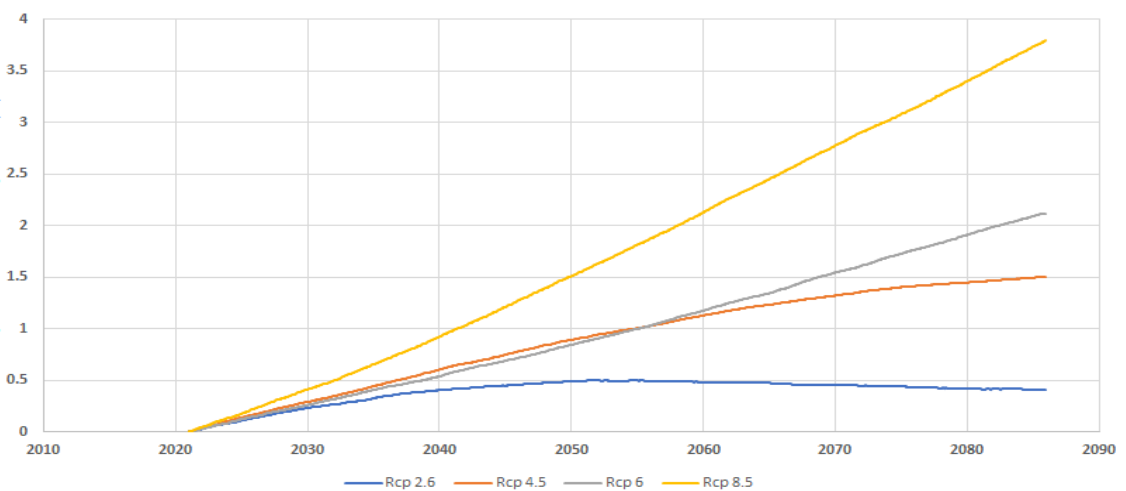
in correlation to the 2006–2035 period, ranges from 0.45 °C (RCP 2.6) to 3.8 °C (RCP 8.5).